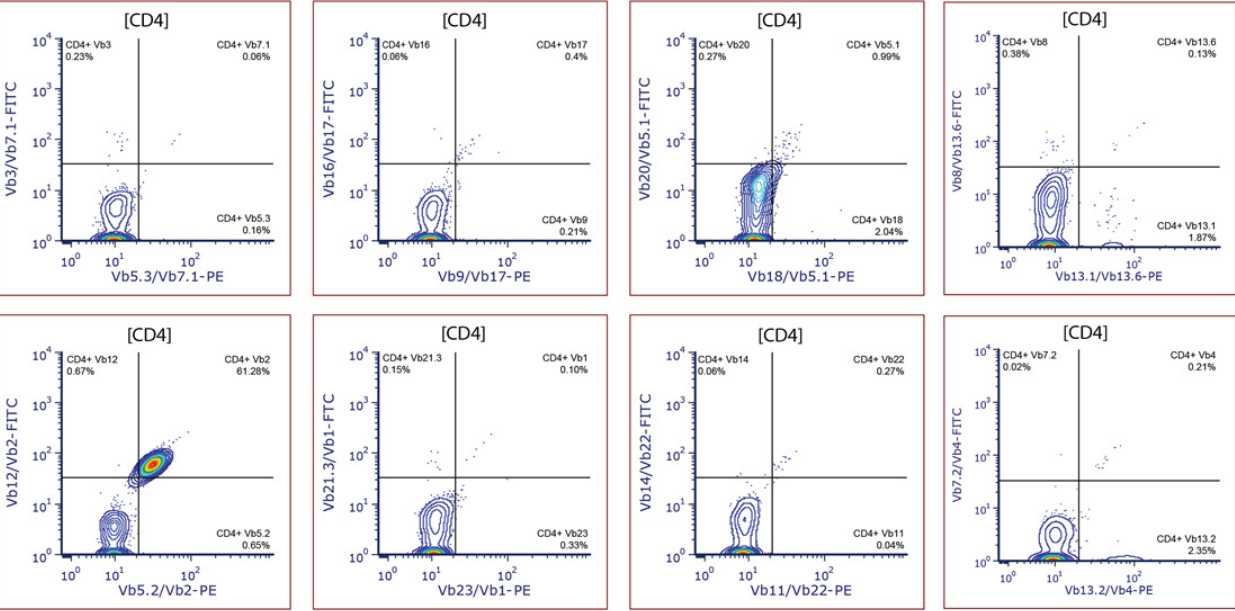
Figure A2. Efficacy of the anti-TCR CDR3 mRNA vaccine in vivo. The experiment presented in Figure 2 was repeated and gave a similar result: mice vaccinated with the mRNA (five C57BL/6 mice) encoding the EL4 TCR CDR3s had a significant (2way ANOVA p value 0.0008) delay in tumour growth compared to untreated (six C57BL/6 mice).